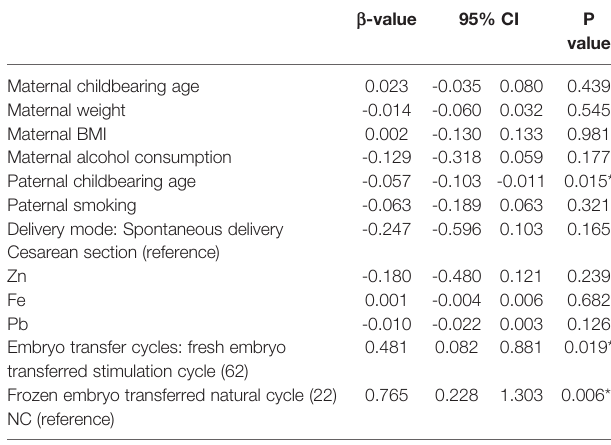
TABLE 5 | Multiple linear regression analysis of bone mineral density- embryo transfer